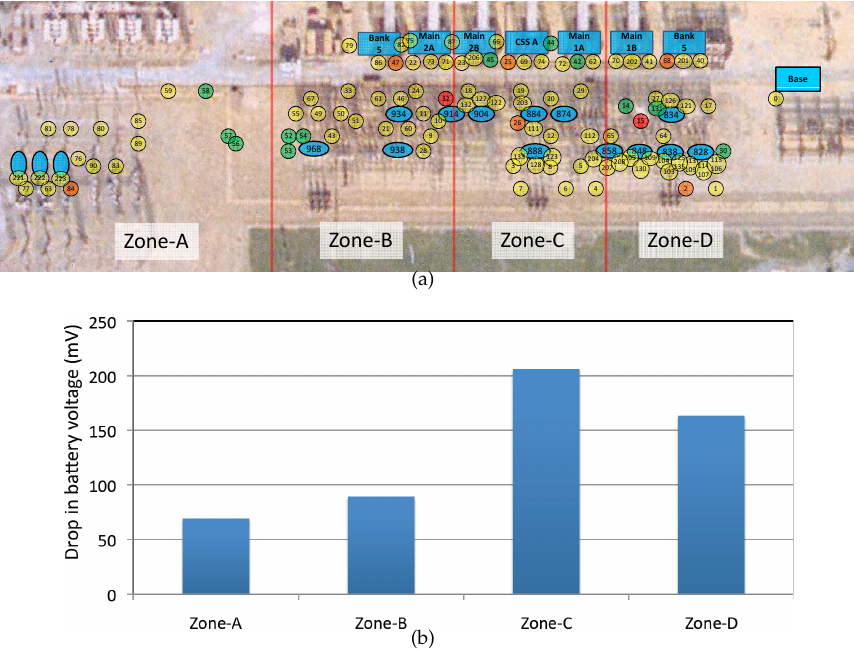
Figure 3. ( a ) Illustration of the layout of ParadiseNet [42], a 122-node WSN deployed for equipment health monitoring from a power substation; and ( b ) the average battery usage of nodes in different geographical zones over a period of five